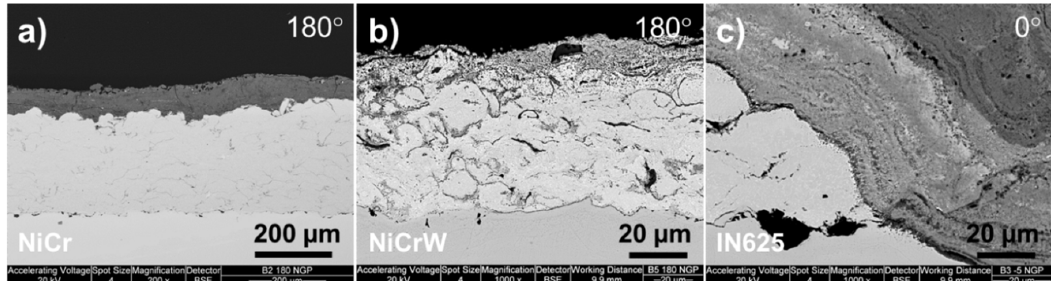
Figure 12. SEM (BSE) images of the HVOF Ni based coatings after exposure at 750 ◦ C for 1300 h. Chromium content of the coatings varied from ( a ) NiCr with 46 wt.% Cr with deposit layer on top of the coating to ( b , c ) NiCrW and IN625 with 21 wt.% Cr.